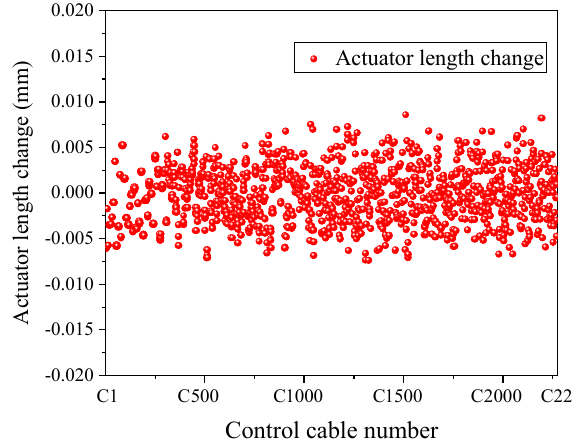
Figure 12. Length change of actuators.